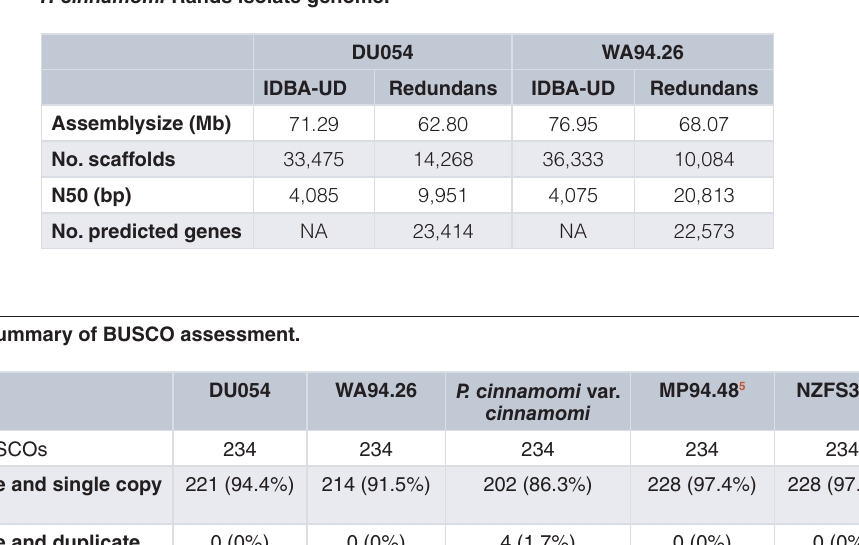
Table 1. Summary of genomic features of assembled genomes comparing IDBA-UD output to scaffolded genome after Redundans processing and